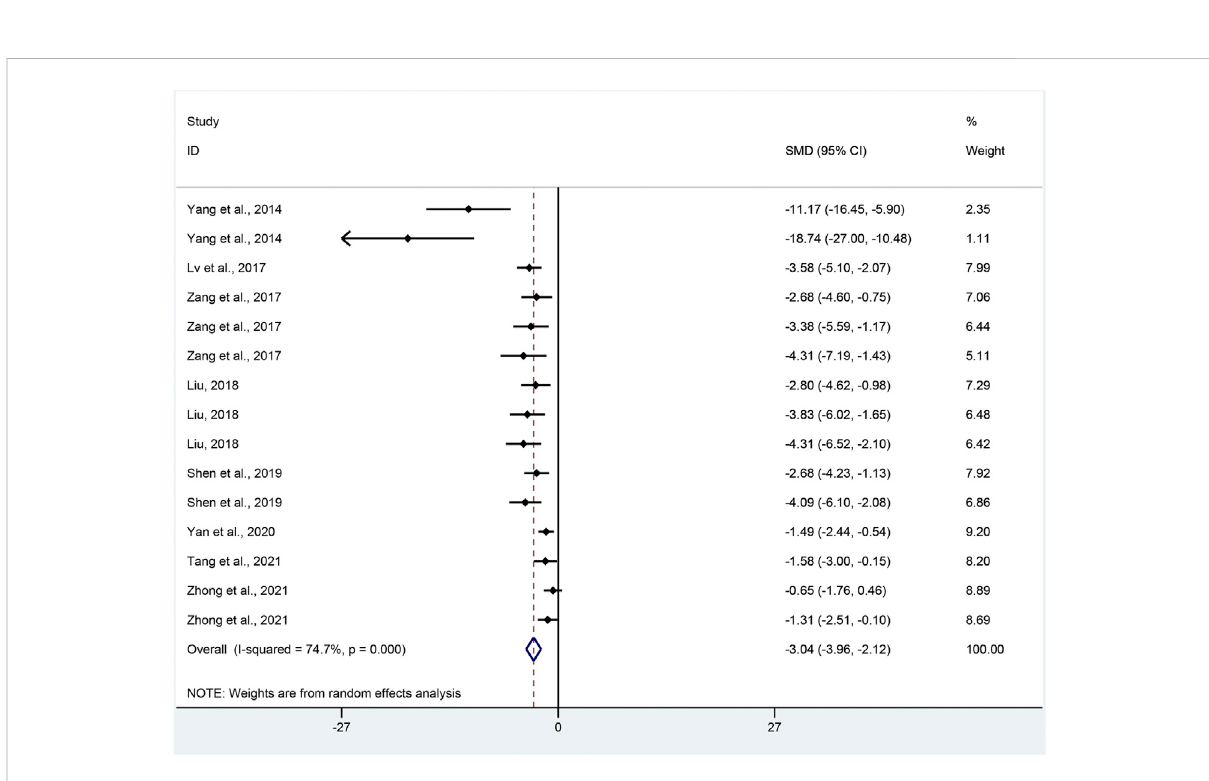
FIGURE 8 Pooled estimate of IL-1 β with